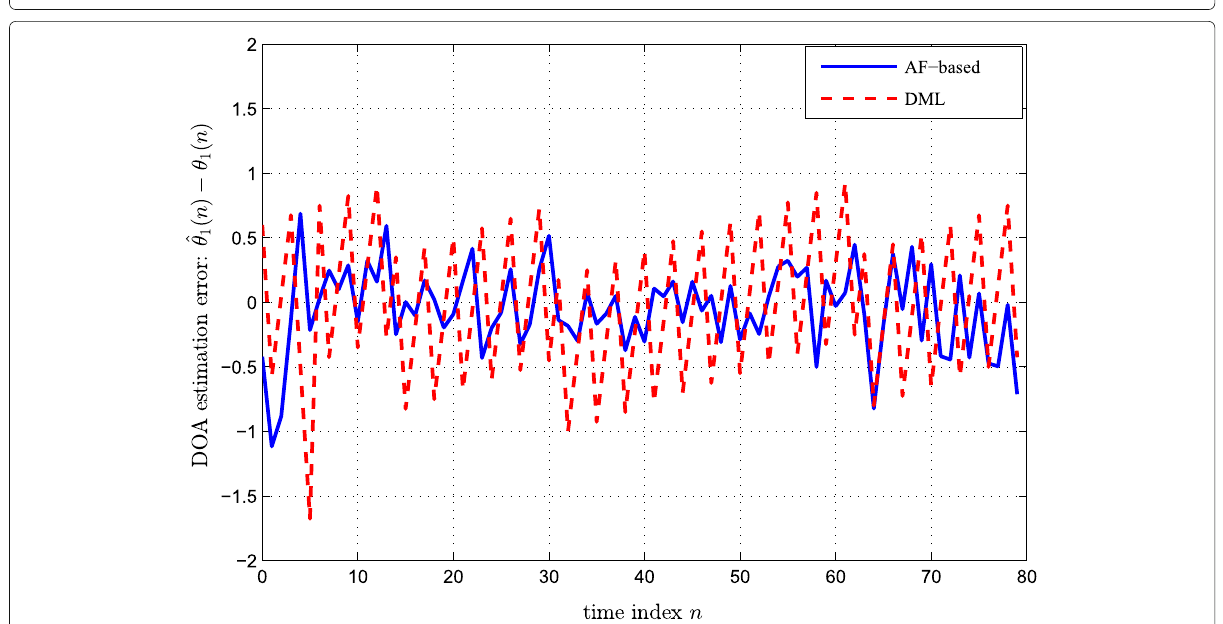
Fig. 6 Tracking error of both estimators with QPSK, K = 2 sources, N = 1, ˙ θ 1 = ˙ θ 2 = 1.175 ° /sample, R = 100, N a = 16, and SNR = 15